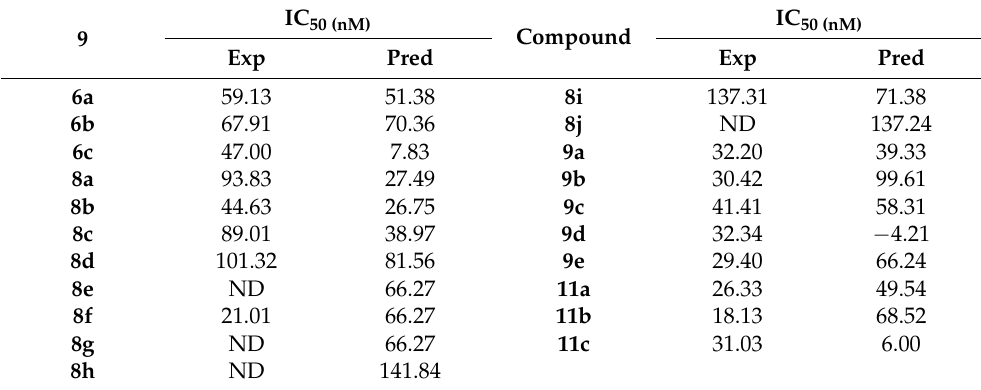
Table 3. The experimental and predicted PDE5 IC 50 values of the test set (series B , D , E and G ) in nM. IC 50 9